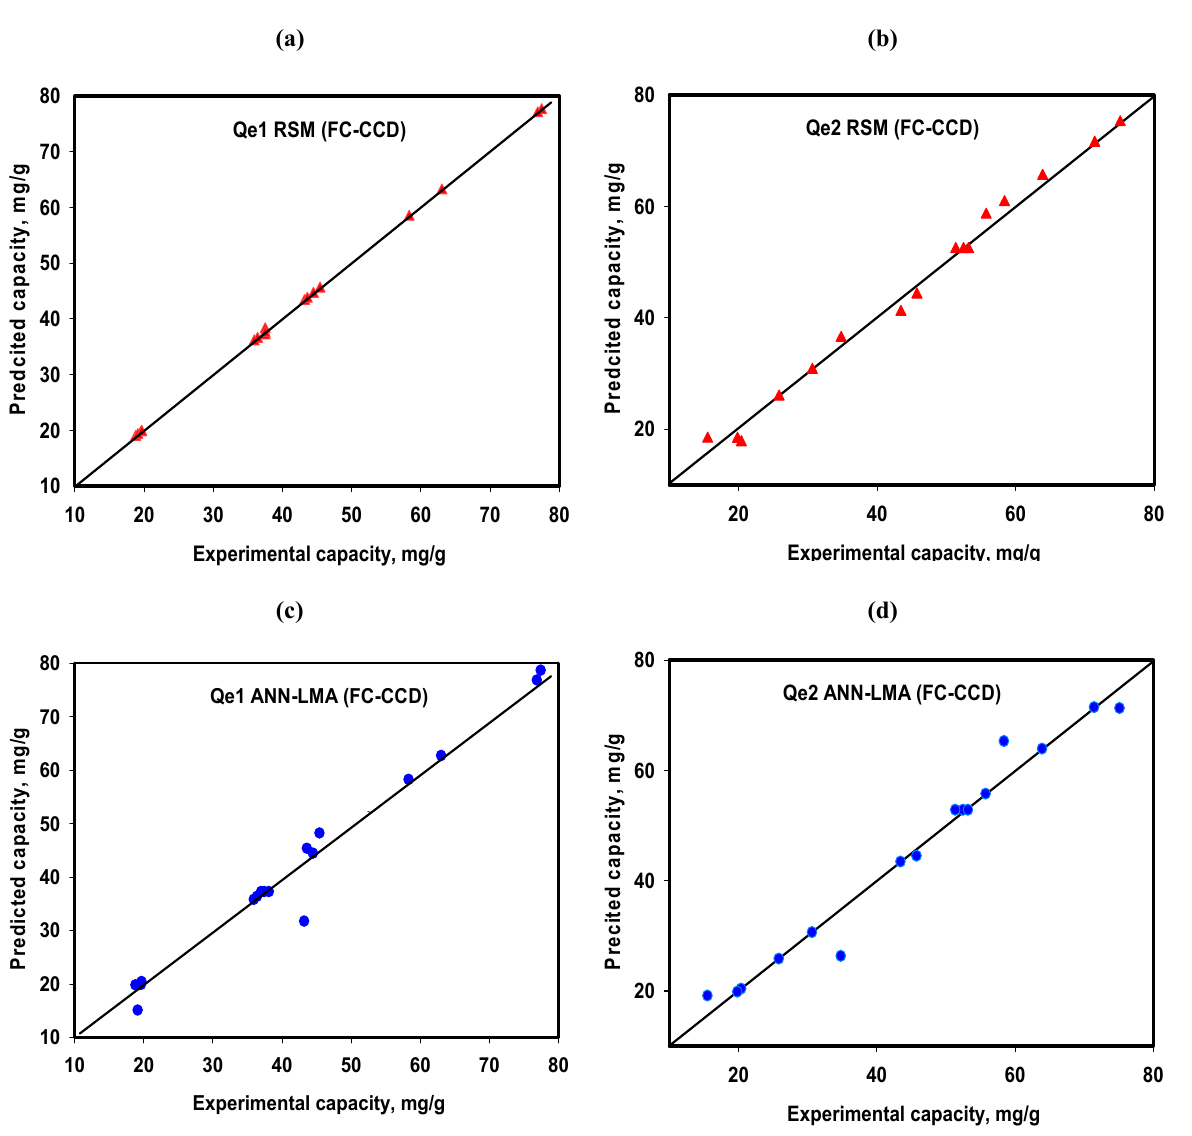
Figure 10. Predicted vs Experimental vs. plots for Qe1 and Qe2 for RSM FCC-CD ( a , b ) and ANN- LMA models ( c , d ).